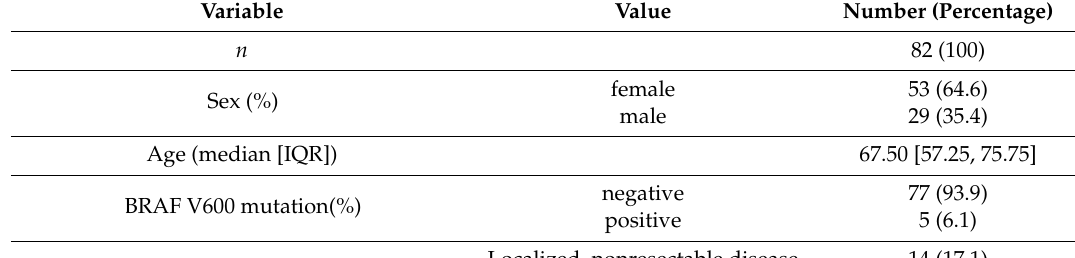
Table 1. The clinicopathological characteristics of